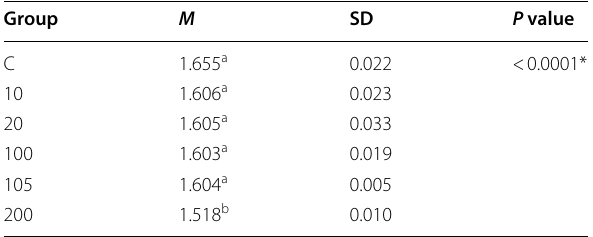
between the effect of different